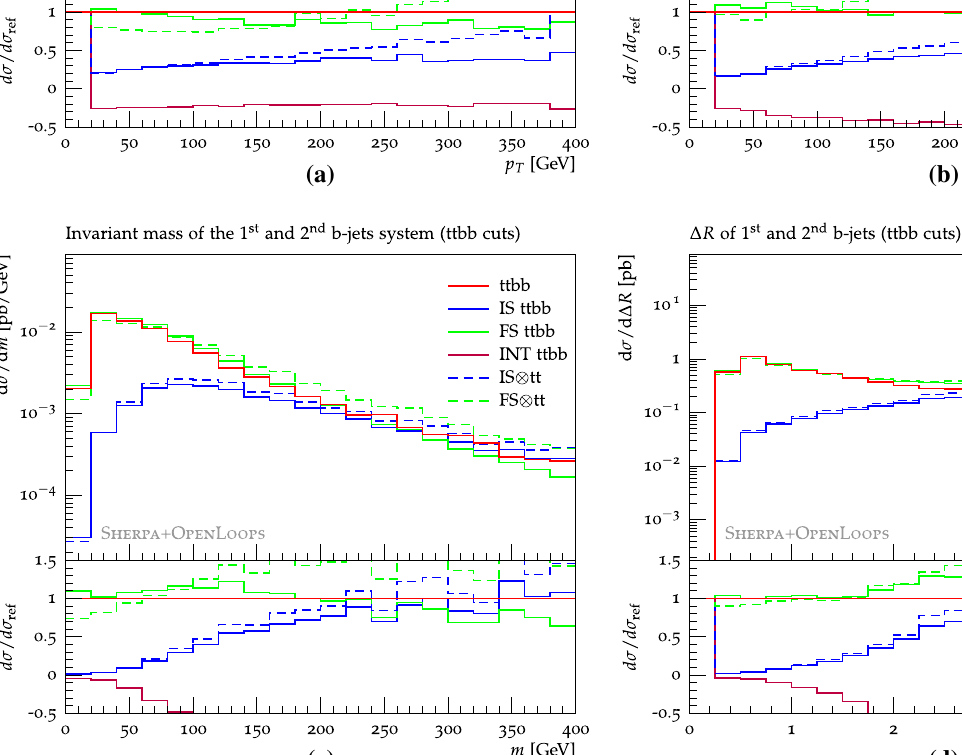
tributions from topologies of IS (solid blue) and FS (solid green) type and their interference (solid purple). This is compared to the gauge- invariant breakdown (4) into IS (dashed blue) and FS (dashed green) parts based on the collinear limits of the t ¯ tb ¯ b matrix element. Note that the q ¯ q channel consists solely of FS g → b ¯ b